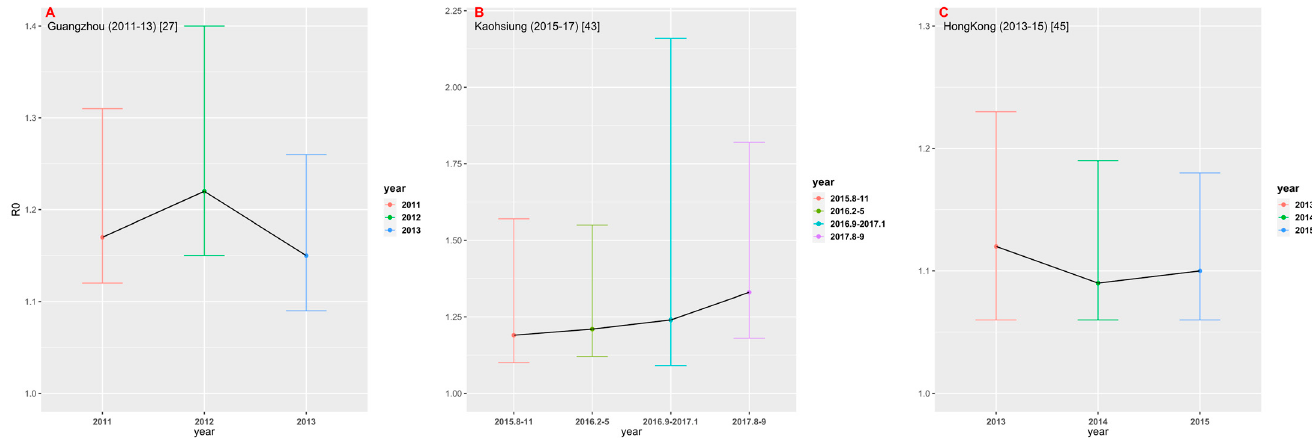
Figure 6. Comparison of R 0 in different time periods in the three regions: ( A ) Guangzhou; ( B ) Kaohsiung; and ( C ) Hong Kong.